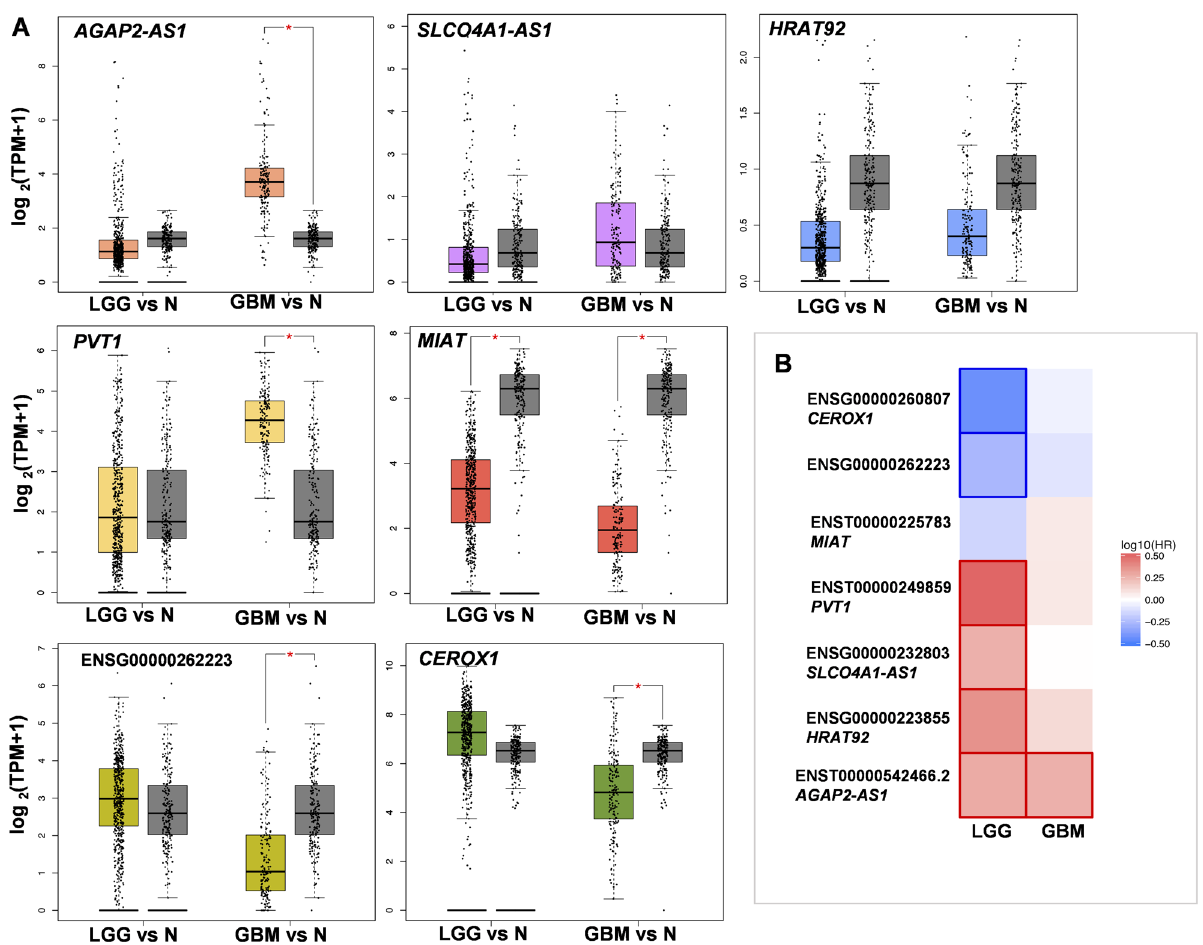
Figure 3. lncRNAs analysis on Gepia platform. ( A ) lncRNAs gene expression (log 2 (TPM + 1)) in low grade glioma (LGG, n = 518), glioblastoma (GBM, n = 163) and normal tissue (N, n = 207) for AGAP2-AS1, SLCO4A1-AS1, HRAT92, PVT1, MIAT, ENSG00000262223 and CEROX1. Significant difference shown as asterisk: * = log 2 FC = 1, p-adj. < 0.01. ( B ) Prognostic impact of lncRNAs expression level based on the survival heat map in LGG and GBM. Heat map shows hazard ratios (HR) in log 10 for different genes. The red and blue blocks denote higher and lower risks, respectively. The rectangles with frames mean the significant (FDR p-adj. > 0.01) unfavorable and favorable results in prognostic m6A modifications of glioma associated lncRNAs. Numerous lncRNAs are shown to be deregulated in glioblastoma and associated with glioma pathogenesis and GSCs properties 36,37 . Nevertheless, m6A RNA modification profile of deregulated lncRNAs requires further exploration. Thus, here we checked m6A modifica- tions of previously reported glioma associated lncRNAs: MALAT1, NEAT1, XIST1, TUG1, CRNDE, LINC00461 , and HOTTIP . MeRIP-Seq analysis detected three m6A peaks in MALAT1 lncRNA that previously was shown to play an important role in regulating the expression of stemness markers and GSCs proliferation 37,38 (Supplementary Fig. S3). The peak localized at the 5 ′ end of MALAT1 transcript revealed slightly higher m6A enrichment (1.4- fold, p = 2.8 × 10 −6 ) in U87-MG cells as compared to NCH421K. The remaining two peaks were similar between cell lines. NEAT1 was also highly modified at the 5 ′ end in both cell lines, nevertheless the peak was 3.1-fold more (p = 3.9 × 10 −17 ) enriched in U87-MG as compared to NCH421K (Fig. 4A; Supplementary Fig. S3). Five relatively low m6A peak enrichment signals were detected in XIST of which only one was significantly enriched in NCH421K cells (p = 0.002, 27.6-fold). m6A signals were localized at the 1st and the last 6th exon of XIST (Sup- plementary Fig. S3). TUG1 previously associated with self-renewal of GSCs and tumor development 39,40 in present study was found to be highly m6A methylated in both cell lines. In total 9 m6A peaks were detected that were localized in all TUG1 exons (Supplementary Fig. S3). The analysis revealed single differentially methylated m6A peak (localized in the last exon) to be more (1.37-fold, p = 4.1 × 10 −3 ) enriched in NCH421K cells as compared to U87-MG. Next lncRNA that was shown to be deregulated in GSCs— CRNDE in the present study was found to be lowly m6A methylated at two sites of which one peak (localized at the 5 ′ end) showed different enrich- ment between cell lines (3.9-fold, p = 3.7 × 10 −4 ) with the higher enrichment in NCH421K cells (Supplementary Fig. S3). Seven m6A peaks were detected in LINC00461 of which 5 were localized in RefSeq exons of the lncRNA